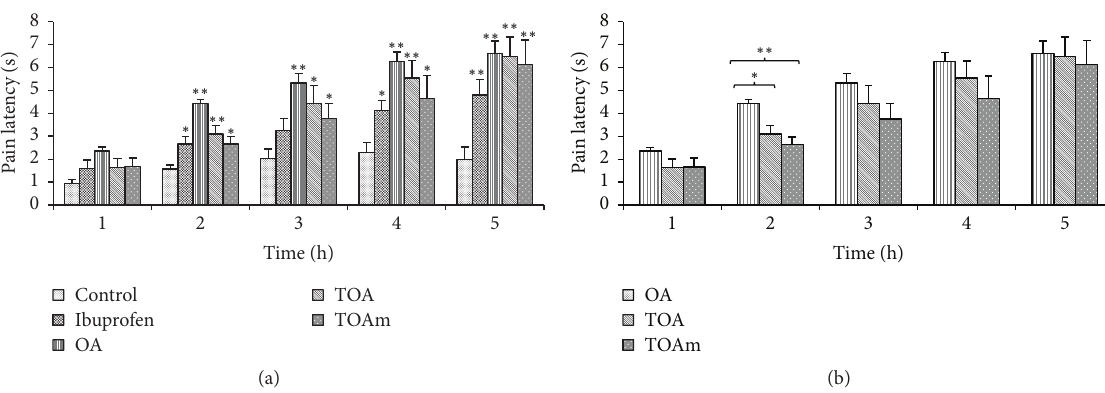
Figure3:EffectoftrifluoroacetylderivativesofOAonpainlatencytoradiantheatandofOA(oleanolicacid),TOA(3-trifluoroacetyloleanolic acid), TOAm (28-methylester, 3-trifluoroacetyloleanane), and ibuprofen (standard drug) on latency to radiant heat. Values are presented as mean reaction time in seconds ± SEM for 6 animals; ∗ 𝑝 < 0.05 and ∗∗ 𝑝 < 0.01 . (a) shows a comparison of the tested compounds against control group, whereas (b) shows the comparison of the semisynthesized trifluoroacetyl compounds with OA.